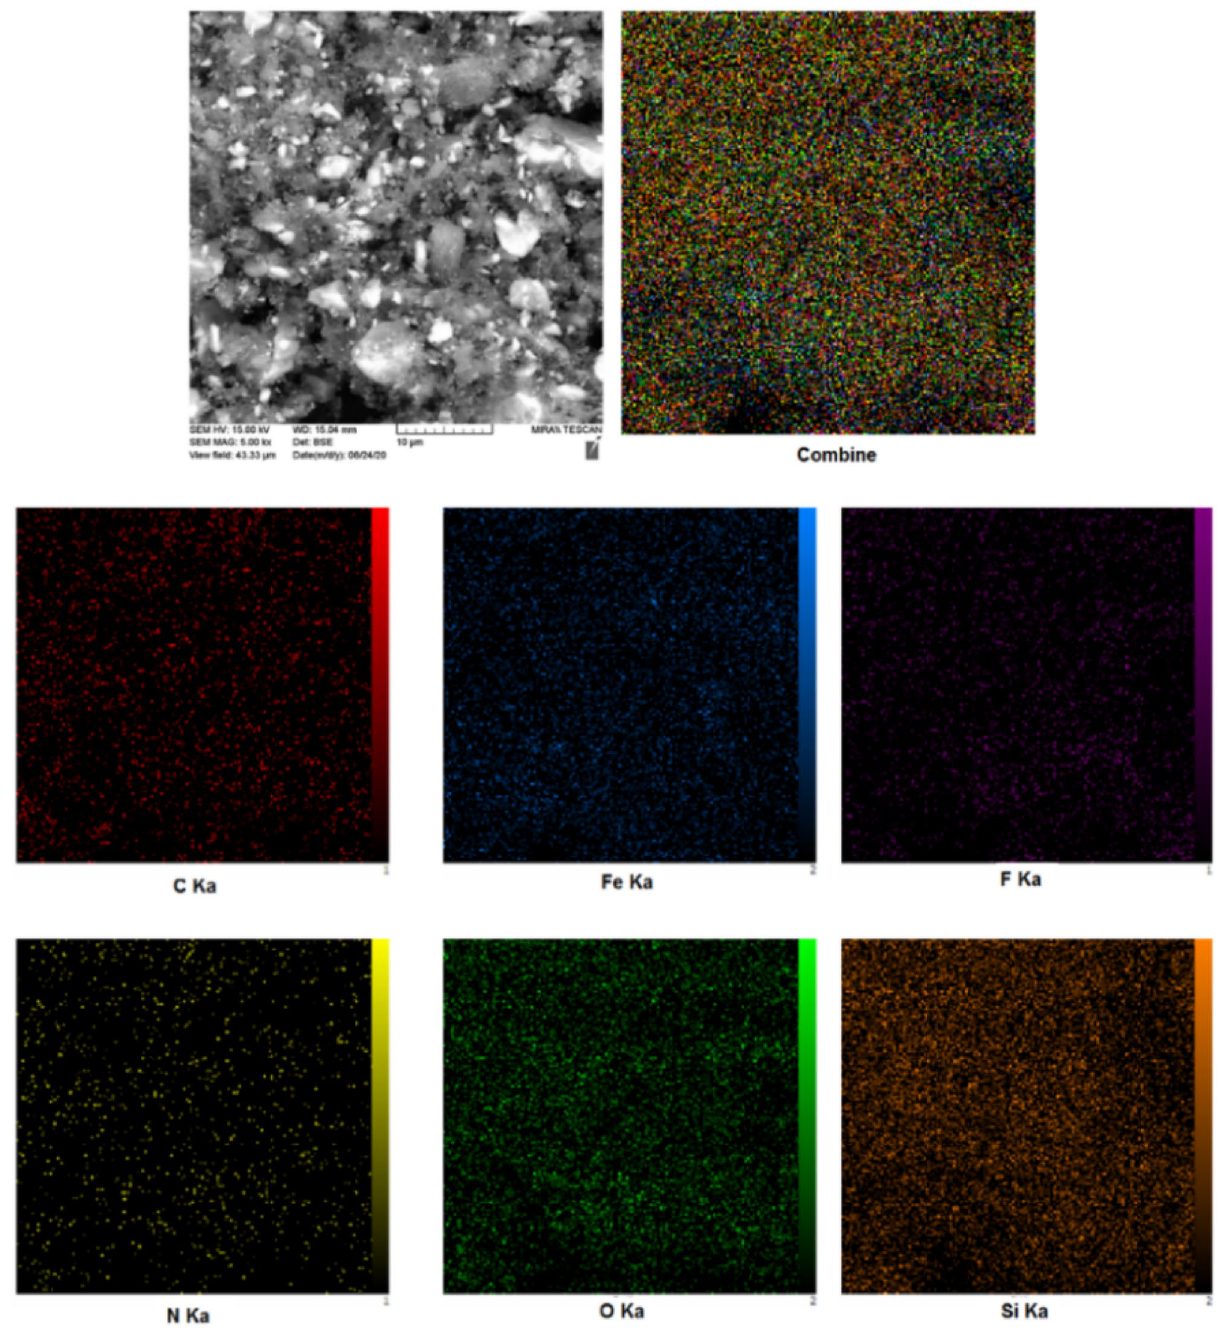
Figure 3. Elemental mapping analysis of Fe 3 O 4 @SiO 2